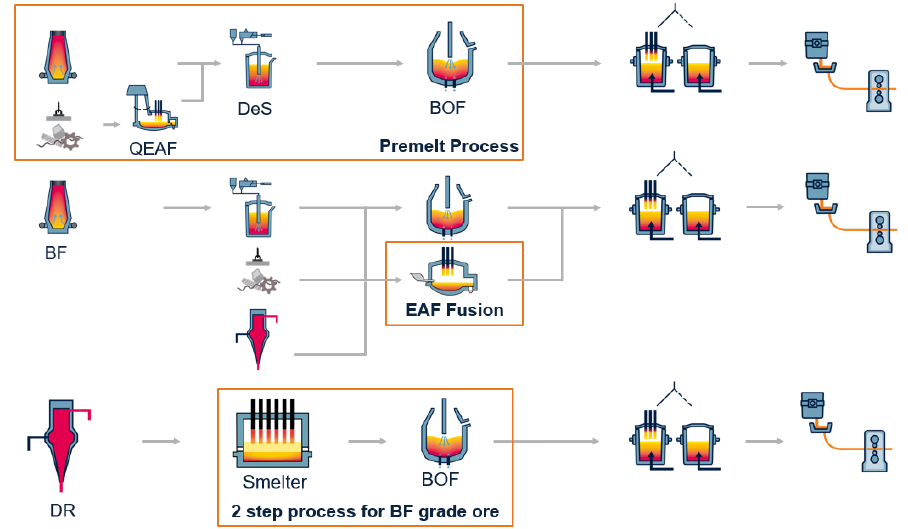
Figure 13. Hybrid EAF–BOF plants and possible routes for the transformation of BF grade ore based integrated steelmaking.